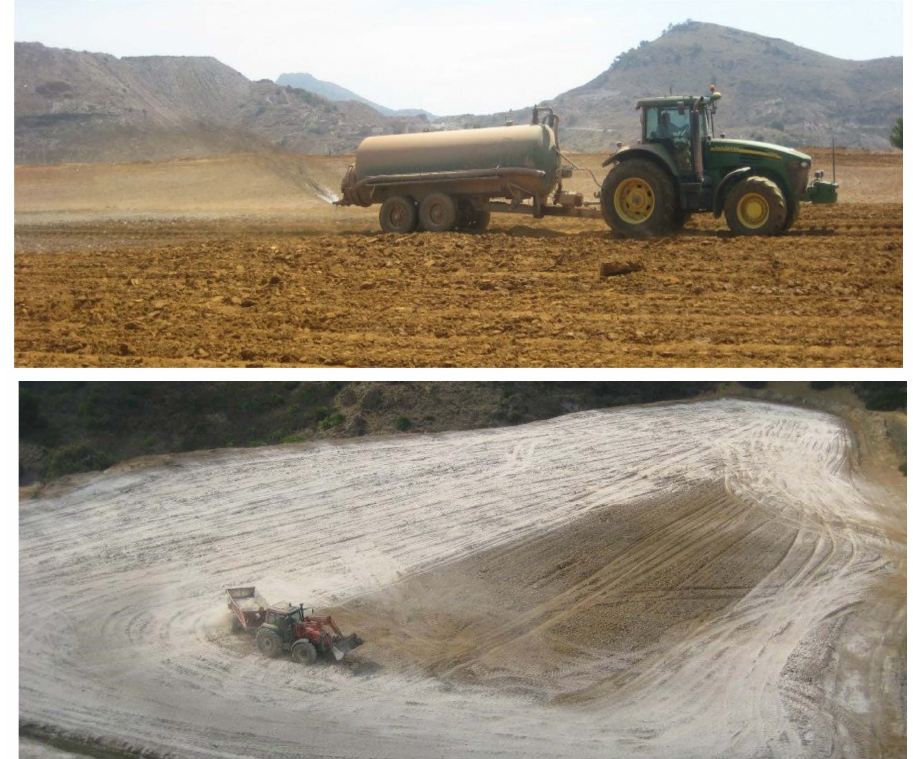
Figure A5. Detail of the application of amendments in Case Study